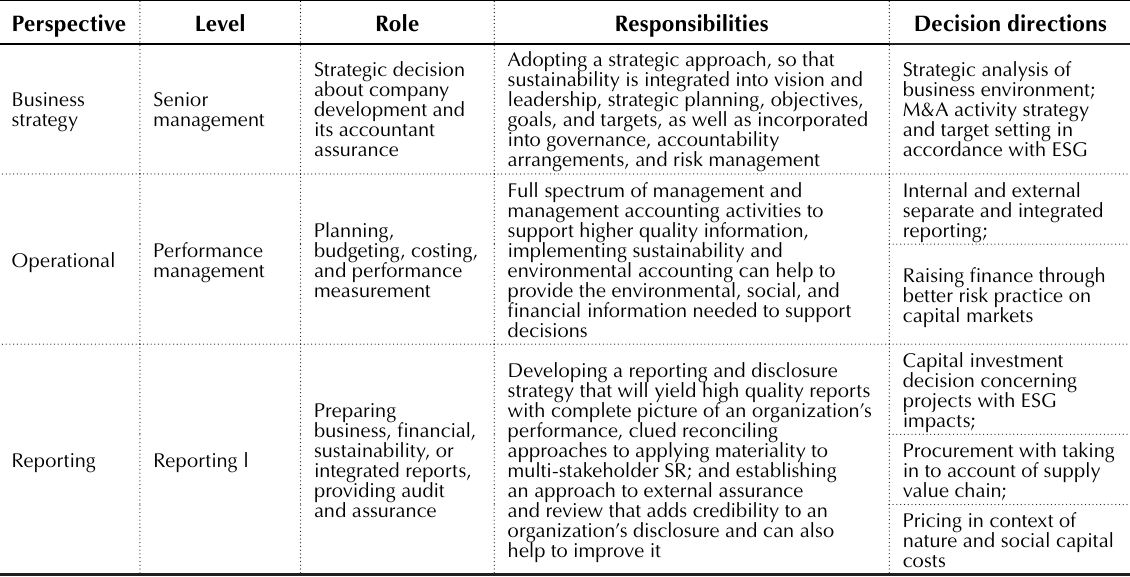
Table 2. Role, responsibilities and decision direction on corporate sustainability perspective